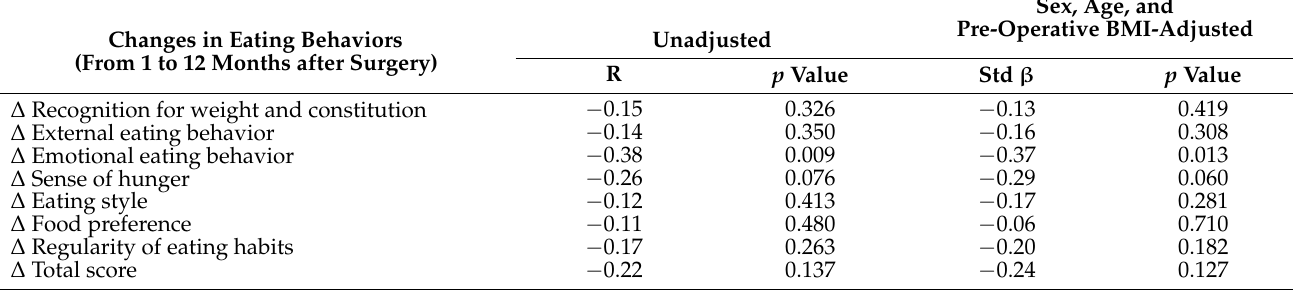
Table 4. Correlations between changes in eating behavior scores from 1 to 12 months after surgery and %TWL at 12 months after surgery.